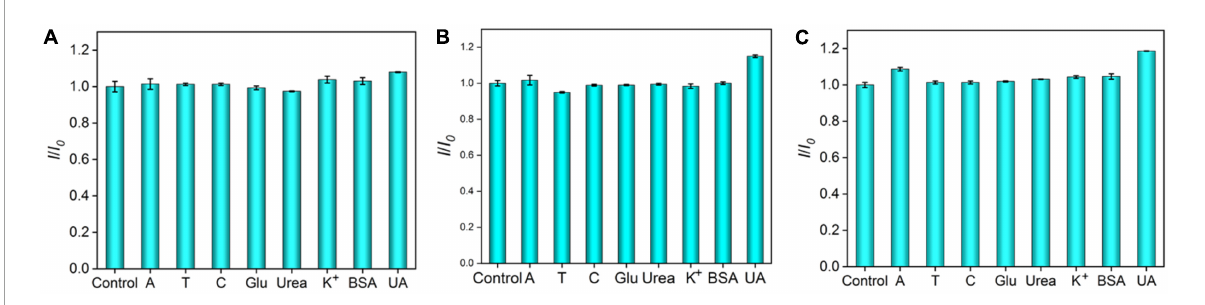
FIGURE6 Anodic peak current ratio ( I / I 0 ) at the VMSF/ITO electrode in PBS (0.1 M, pH 7.0) containing 0.1 µ M Ru(bpy) 32 + and 0.5 µ M G (A) , 1 µ M Ru(bpy) 32 + and 5 µ M G (B) , 10 µ M Ru(bpy) 32 + , and 10 µ M G (C) in the absence ( I 0 ) or presence ( I ) of the interferents. The concentration of interfering species was 10-fold higher than